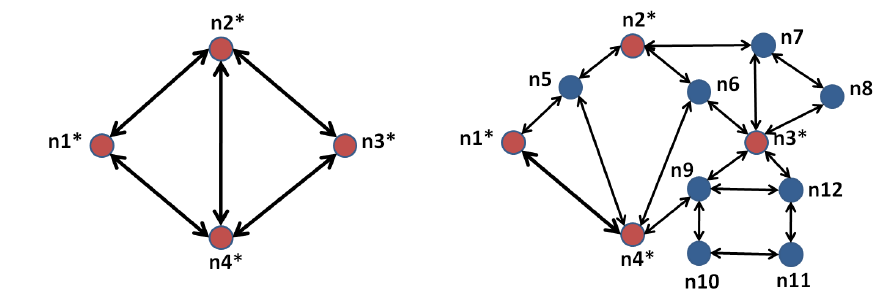
Figure 2. Different representations of the same area: aggregated ( left ) and disaggregated ( right